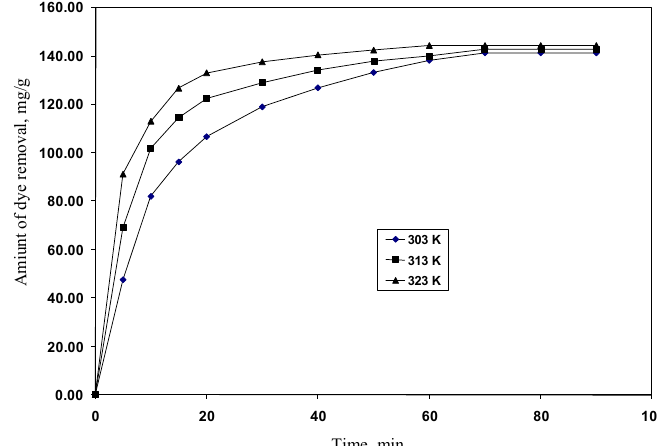
Figure 7. Effect of Temperature on the removal of AG 25 onto